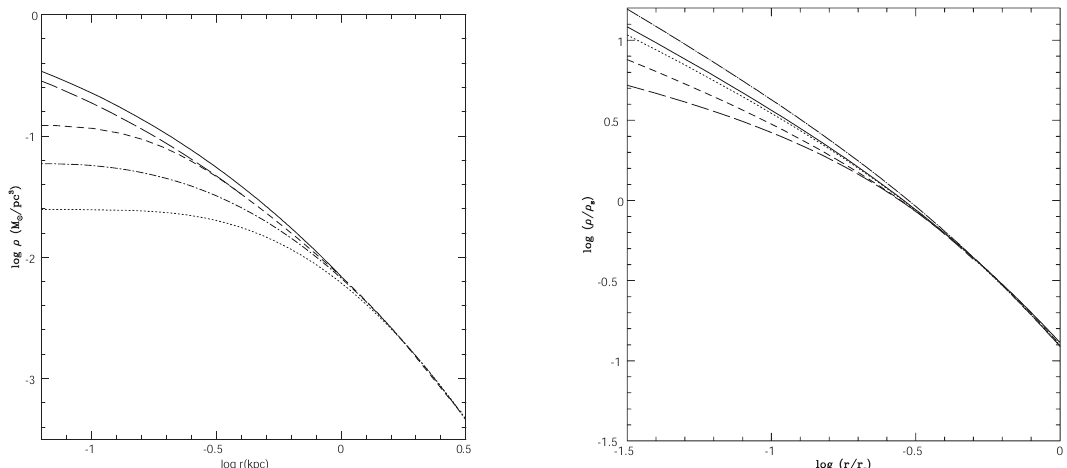
Figure 6. Left panel: evolution of the density profile of a 10 9 M (cid:12) halo [166] (see the discussion on the DFBC scenario). The profile at z = 10,3,2,1, and 0, are represented by the solid line, long-dashed line, short-dashed line, dot-dashed line, and dotted line, respectively. Right panel: evolution of the density profile of a 10 14 M (cid:12) halo of [166] (see the discussion on the DFBC scenario). The dot-dashed line represents the total mass density profile (DM+Baryons) at z = 0, while the DM profile at z = 3,1.5, 1 and 0 is represented by the solid line, dotted-line, short-dashed line, and long-dashed line, respectively (figure reproduced from